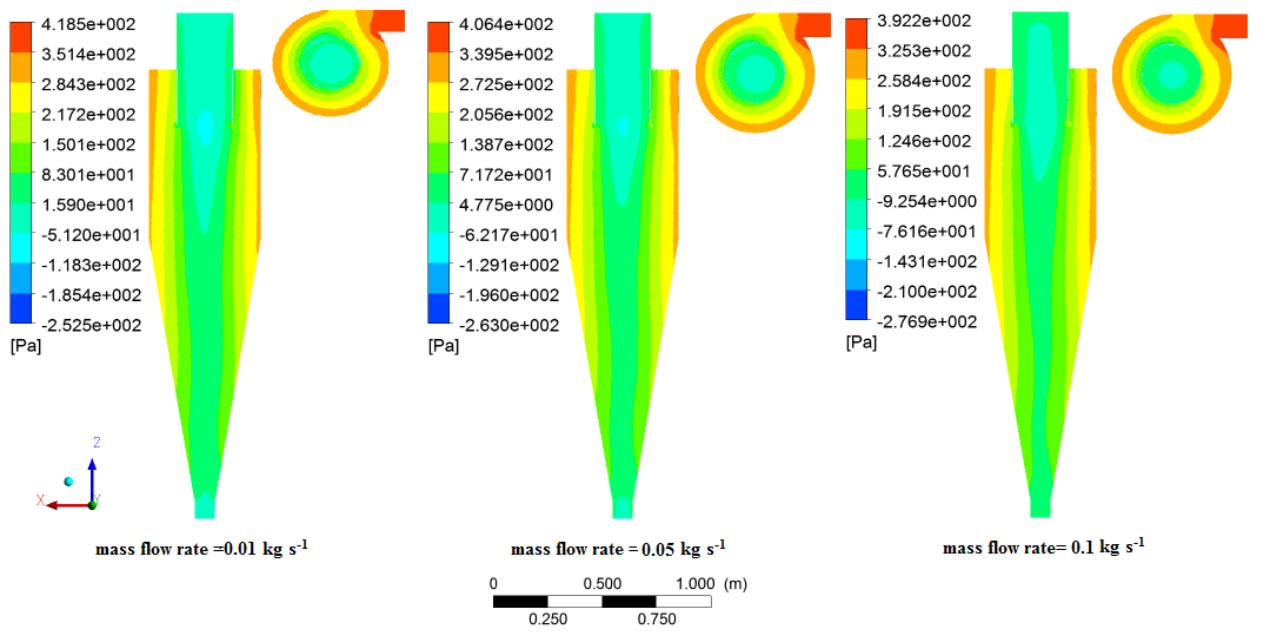
Figure 18. Static pressure contours in various mass flow rates.